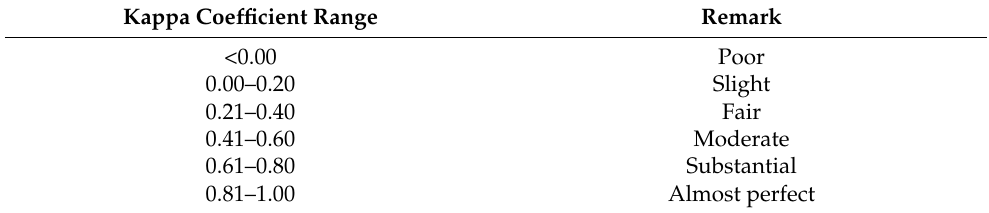
Table 2. Kappa statistics